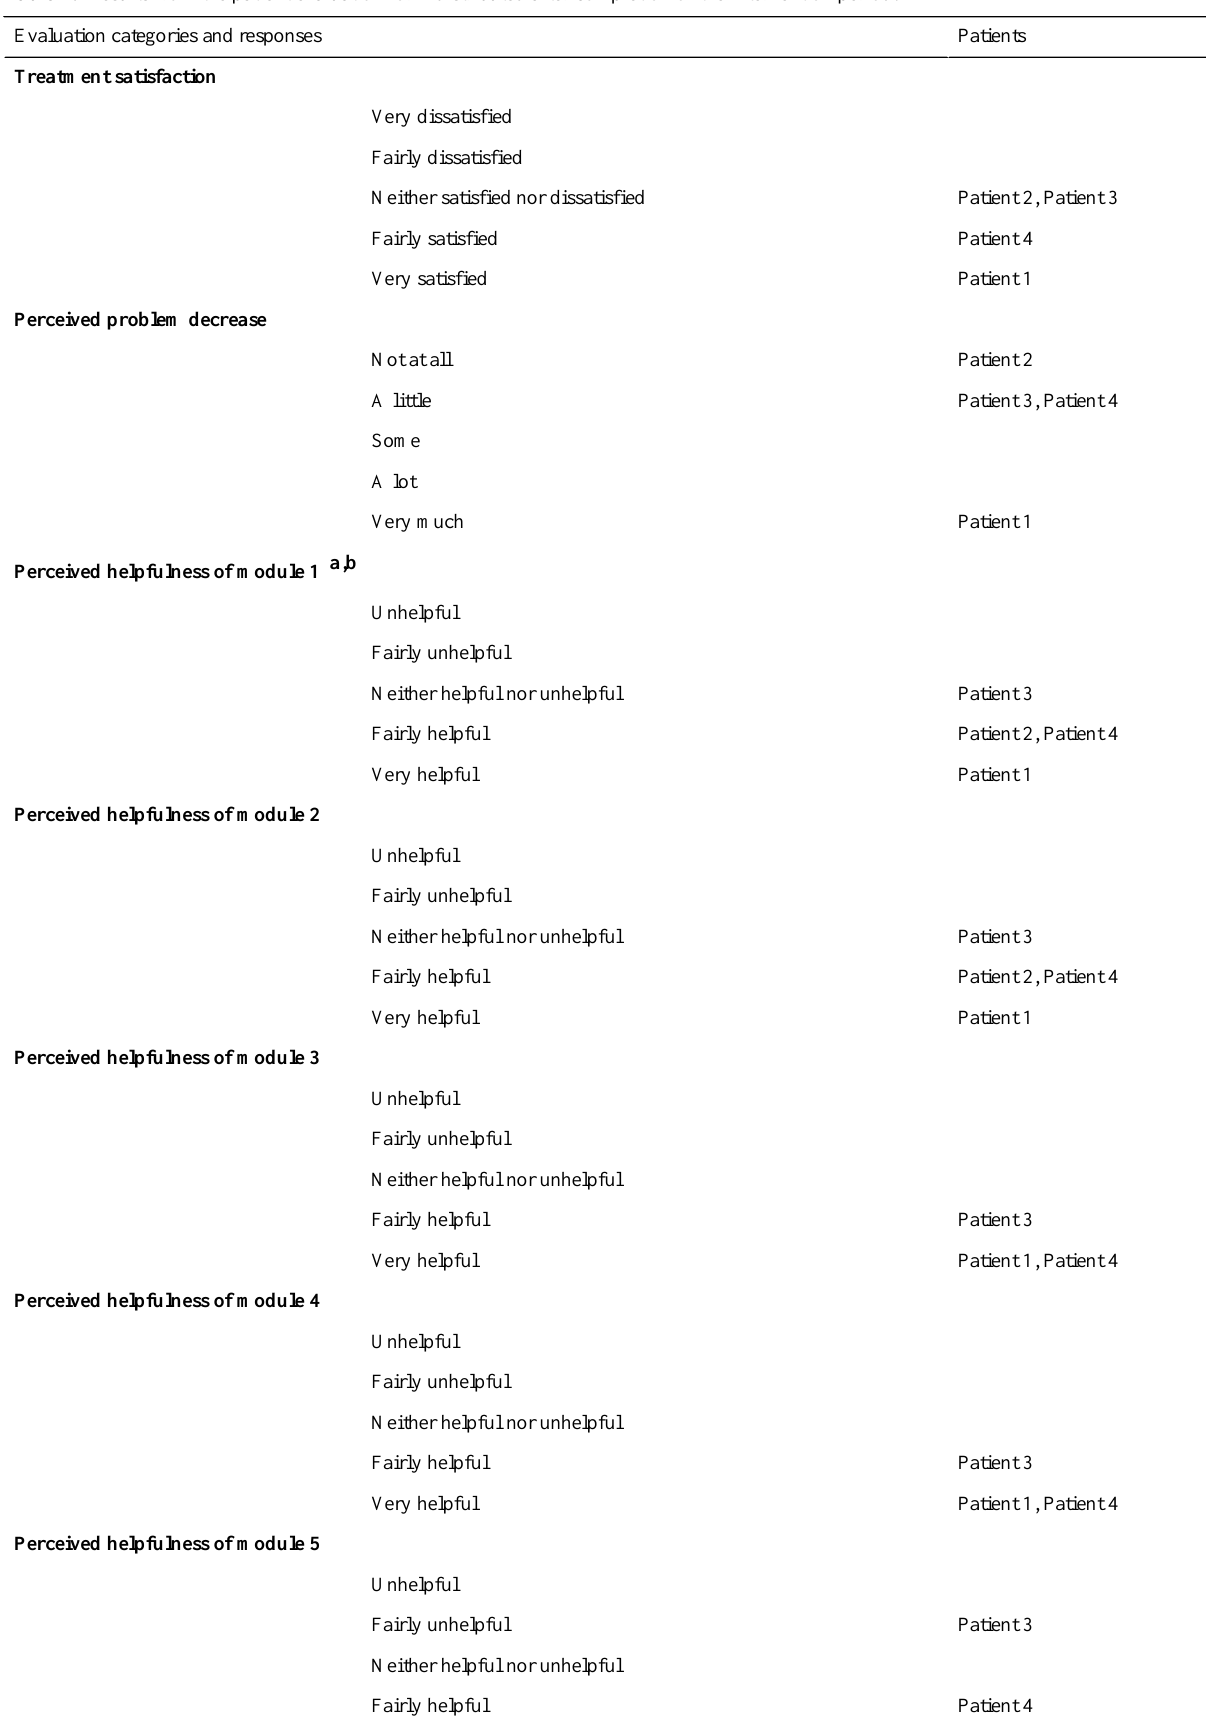
Table 2. Results from the patient evaluation form distributed after completion of the intervention